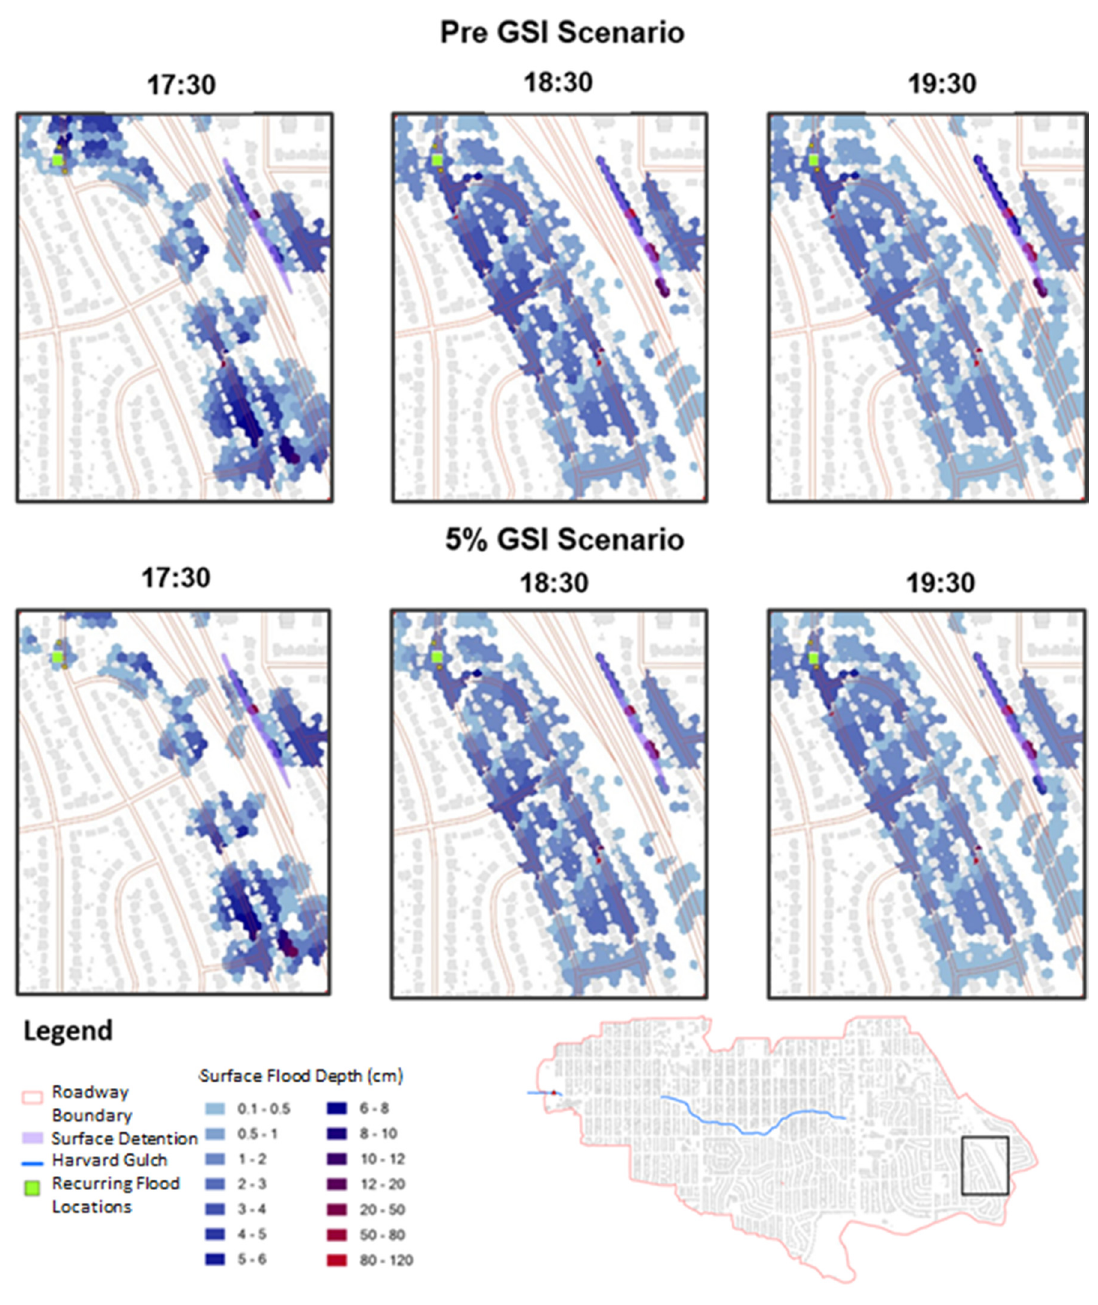
Figure 8. The surface flood extent and depth for a small portion (0.02 km 2 ) of the watershed at select times for the pre and 5% GSI scenarios.